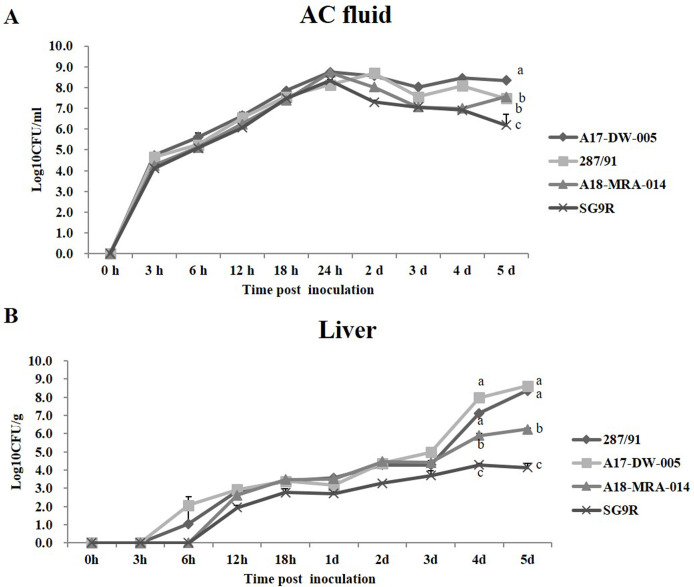
Growth curves of 287/91, A17-DW-005, A18-MRA-014 and SG9R strains
after inoculation with 104 CFU into the AC of 13-day-old
embryonic chicken eggs (n = 3).(A) The mean CFU present in the AC fluid was followed over time. (B) The
mean CFU present in the embryonic liver was followed over time. Each
point represents the mean ± standard deviation of two embryos per group.
None of the strains were recovered from control eggs inoculated with PBS
alone.